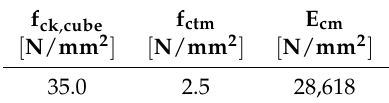
Table 1. Material properties of the concrete.